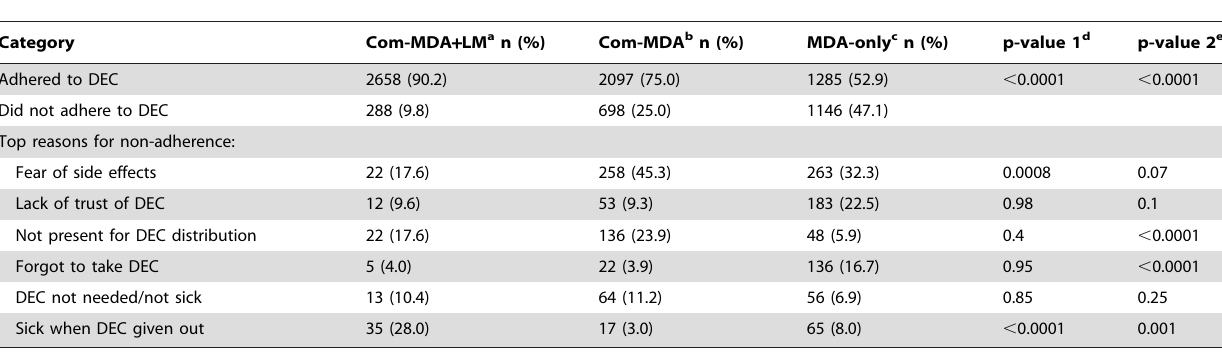
Table 1. Household survey: Rates of adherence and non-adherence to a DEC regimen and reasons for non-adherence during the 2008 MDA, Khurda District, Orissa